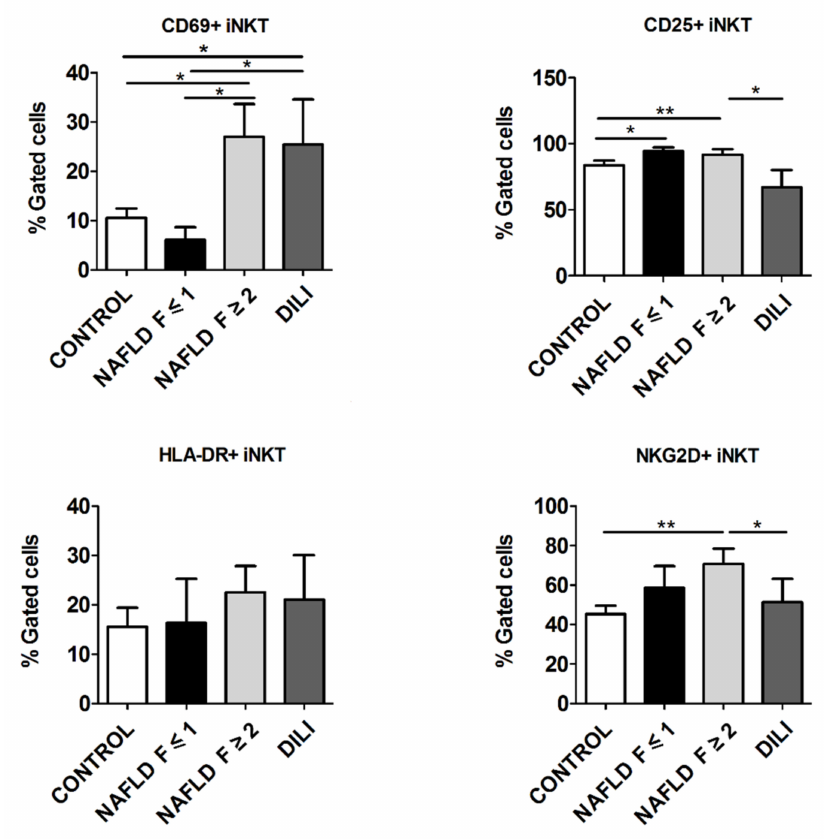
Figure 2. Expression of early (CD69+) and late (CD25+, HLA-DR+) activation markers, and NKG2D+ in invariant natural killer T (iNKT) cells in T lymphocytes from peripheral blood mononuclear cells from healthy controls, non-alcoholic fatty liver disease (NAFLD) and drug-induced liver injury (DILI) patients. Data are presented as mean ± standard error of the mean. * p ≤ 0.05 and ** p ≤